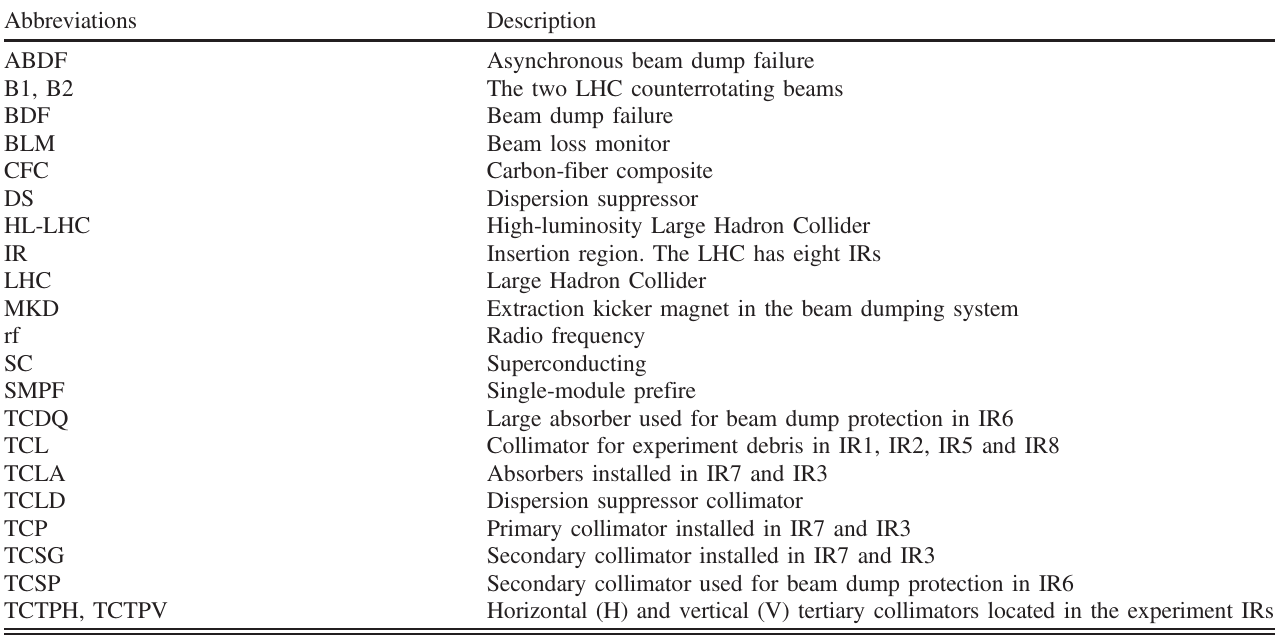
TABLE V. Summary of abbreviations used in this